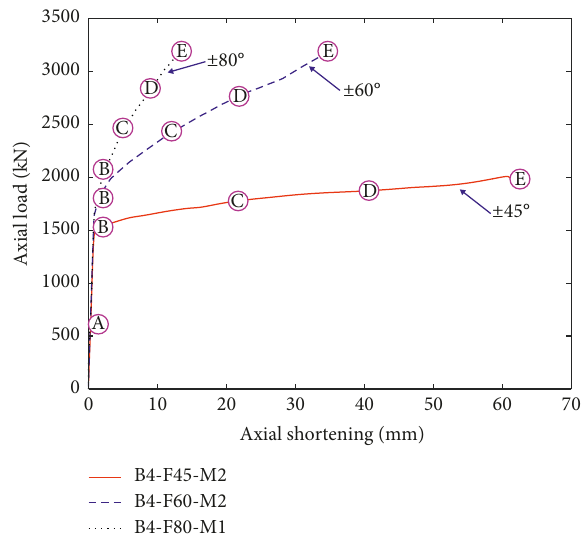
Figure 12: Axial load-axial shortening curves of typical